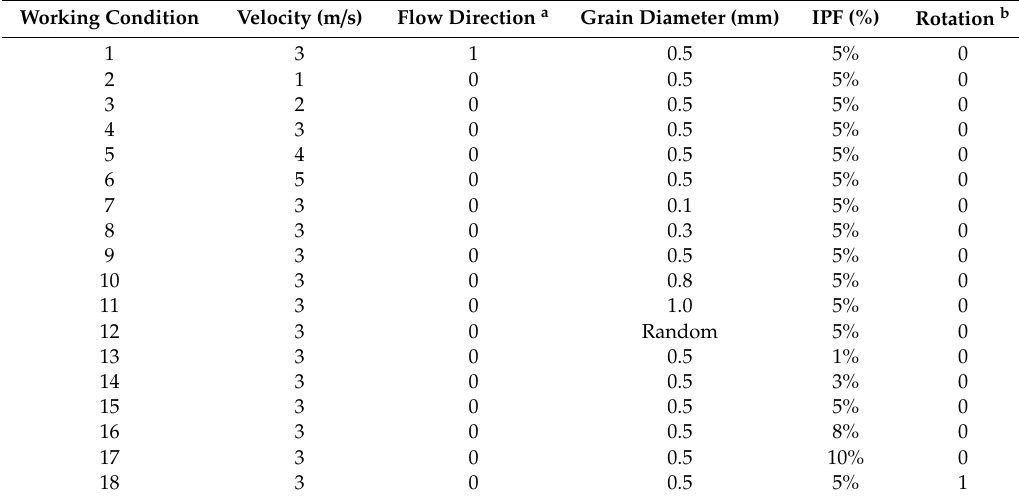
Table 3. Values of di ff erent vibration